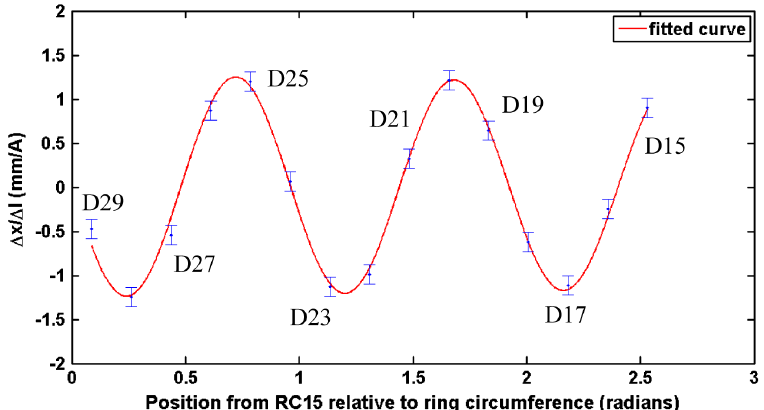
FIG. 6. Measured perturbed horizontal centroid motion (within the midregion of the beam using a 2 ns window) around the ring using a single beam position monitor (BPM at RC15, zero radians). The measured tune is 6 : 541 (cid:4) 0 : 062 with a fit goodness of 0.99. The average error per point is 0 : 1 mm = A .